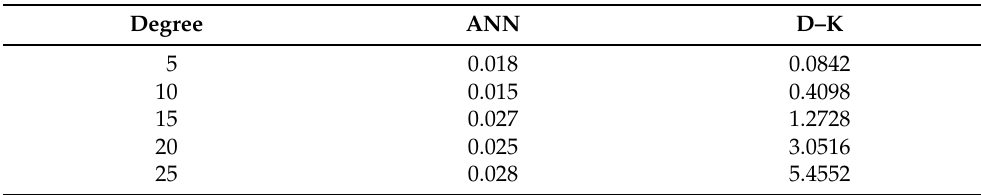
Table 2. Comparison between the ANN approach and the D–K method in terms of the average execution time (in seconds) for polynomials with real and complex roots.